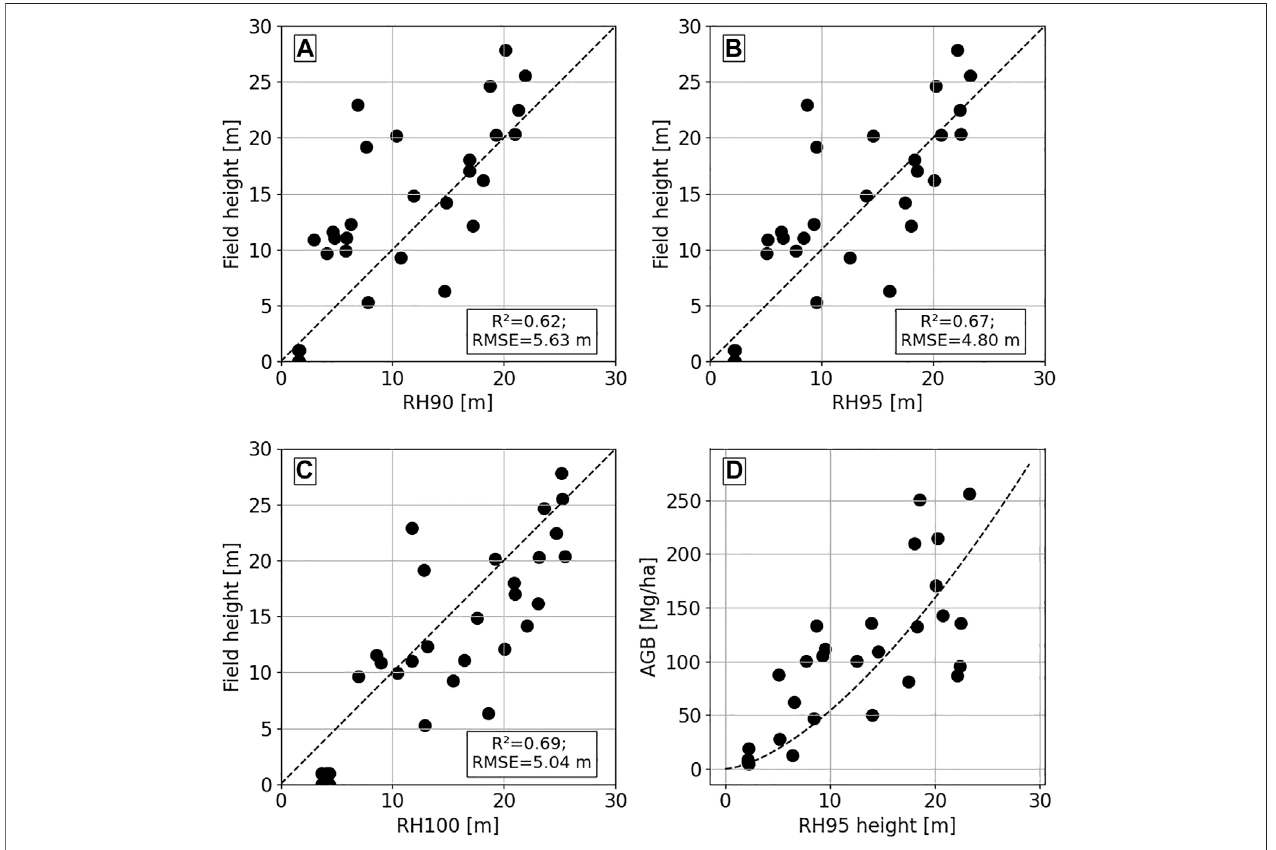
FIGURE 5 | The GEDI RH heights correlated with fi eld-measured height for the plots with overlapping GEDI observations. The RH95 height (B) shows the best performance. The RH95 height is further related to fi eld measured AGB with a power-law relation to generate a GEDI- fi eld AGB allometry.